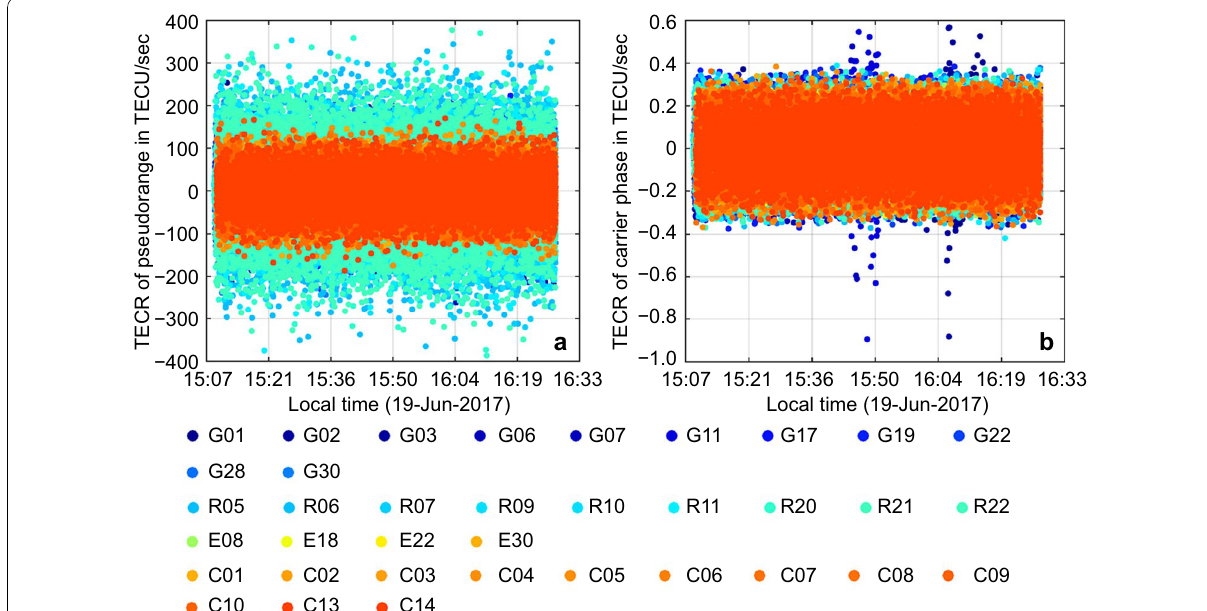
Fig. 5 TECR derived from pseudorange ( a ) and carrier phase measurements ( b ) from GNSS satellites (GPS, GLONASS, Galileo, and BDS). The data were collected at the SS receiver beside the MTR railway line from 15:08 to 16:28 HKT on 19 June